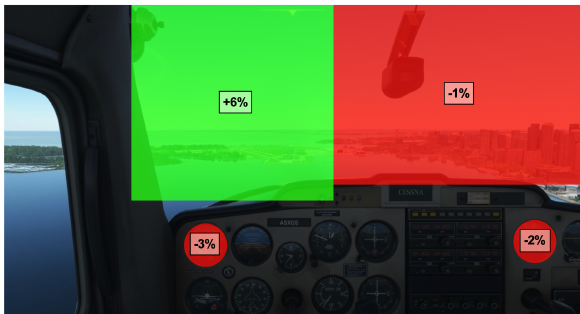
Figure 4. Illustration of the visual stimuli employed during land- ing and the corresponding change in dwell time (%) between easy and difficult conditions. Only significant changes in dwell time are displayed over their corresponding area of interest (AOI) (i.e., airspeed, power, runway, and horizon AOIs). Group mean differ- ences (difficult-easy) are illustrated in red to indicate a decrease in AOI dwell time and green to indicate an increase in AOI dwell time.